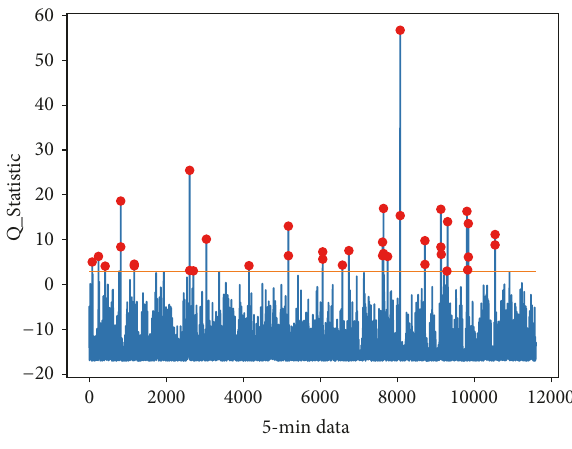
Figure 5: Jumps of the simulated data of the 5-minute interval under the LM test . Referring to the length of the empirical data, we simulate the price data of 58560 time units. Process the data at a 5-minute sampling interval and calculate the value of the LM statistic. Compared with the yellow horizontal reference line for the significance level threshold in the figure, the 32 points marked red are beyond the normal value